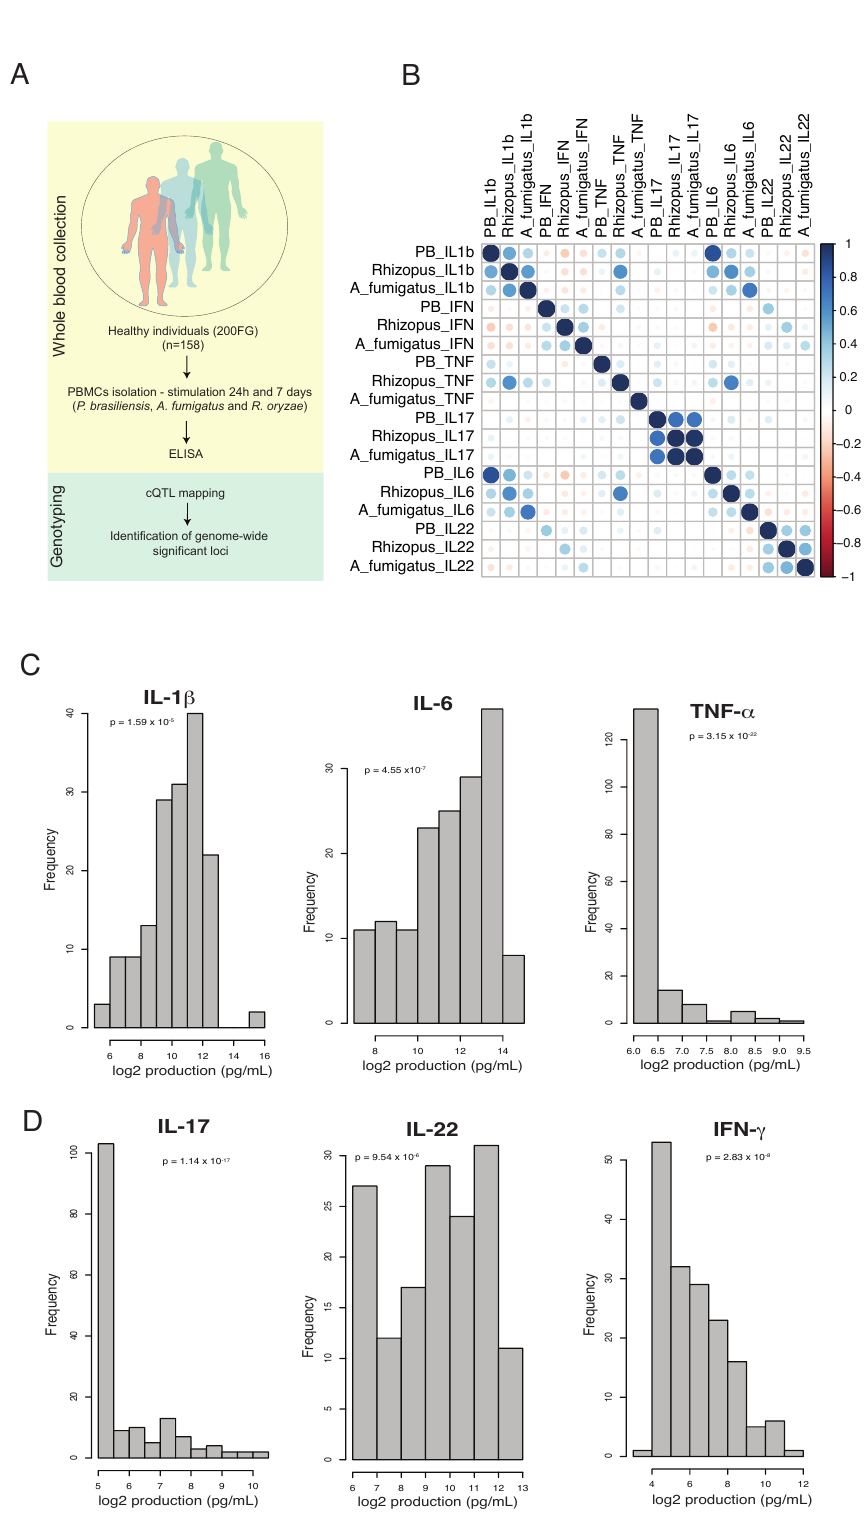
Figure 1. Similarities in innate and acquired cytokine profiles induced by P. brasiliensis and other fungi. ( A ) Overview of the study. ( B ) Spearman correlation coefficients between IL-1 β , TNF, IL-6 (24 h of incubation), IFN γ , IL-22 and IL-17 (seven days of incubation) levels after PBMC stimulation with heat-killed yeasts of P. brasiliensis, conidia of A. fumigatus and or R. oryzae (2.5 PBMCs:1 fungus; cytokines were measured by ELISA in pg/mL); ( C , D ) Distribution of P. brasiliensis -induced cytokines after 24 h ( C ) and seven days ( D ), Log2-transformed values were used, and p-value was assessed by Shapiro